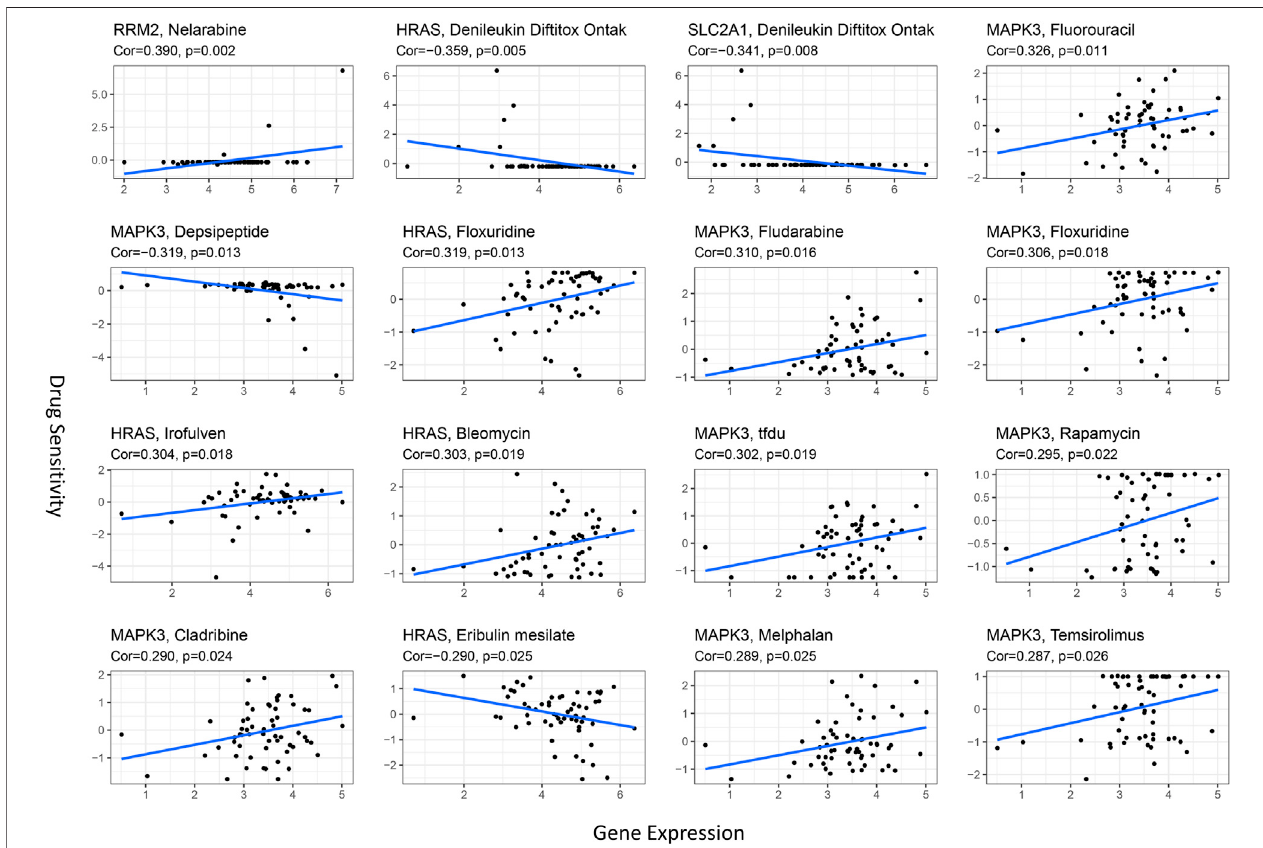
FIGURE 11 | Scatter plots for the association between prognostic hub gene expression in the model and drug sensitivity (top 16 ranked by p -value).